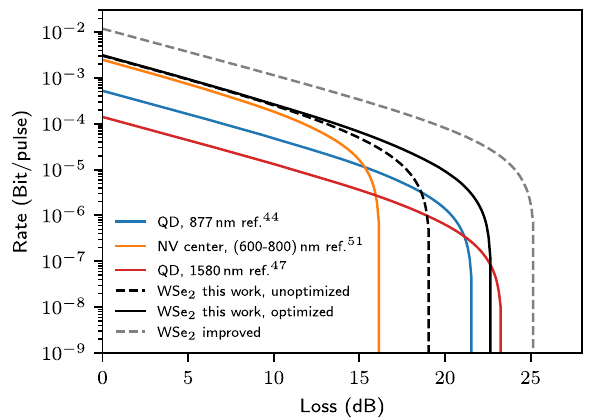
Fig. 4 Benchmarking of our WSe 2 single-photon source against previous QKD experiments. Rate-loss diagram considering our experimental data from Table 1 and the parameters from previous QKD experiments using semiconductor quantum dots (QD) 44 , 47 , and nitrogen-vacancy (NV) centers in diamond 51 (see Methods section “ Parameter optimization ” for details on the key rate calculation). The black curves show the expected performance of our WSe 2 -based source without (dashed line) and with (full line) optimization via temporal fi ltering. Implementing moderate improvements to our source (gray dashed line), tolerable losses exceeding 25 dB become possible, bringing satellite links within reach 28